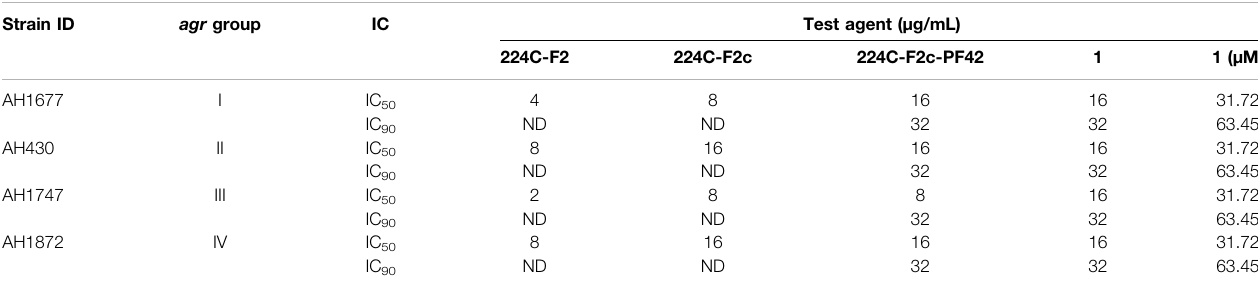
TABLE 3 | IC values of 1 and parent fractions on agr reporter strain fl uorescence